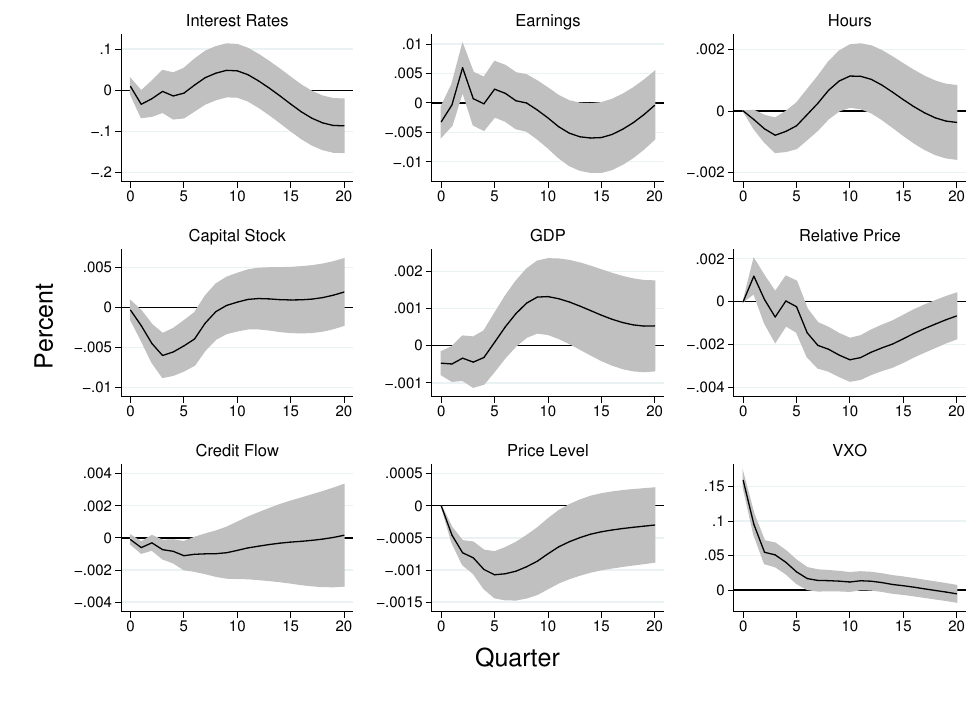
Figure A8. Effects of Uncertainty Shocks when Non-Uncertainty Variables are Ordered First. Notes : This figure shows the effect of one standard deviation increase in the VXO on the US output,